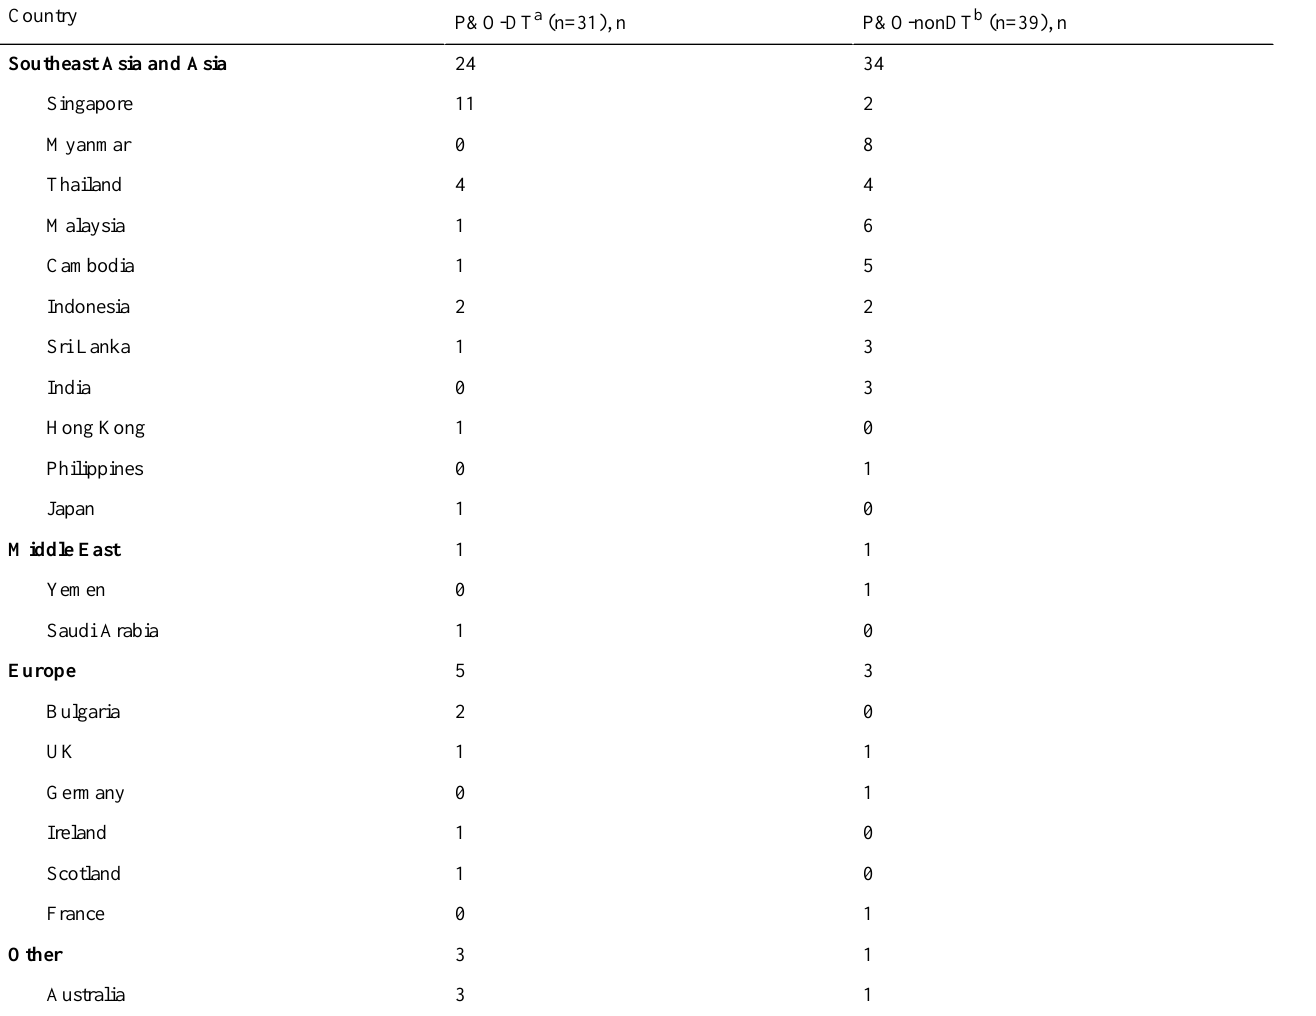
Table 4. Country of prosthetist and orthotist